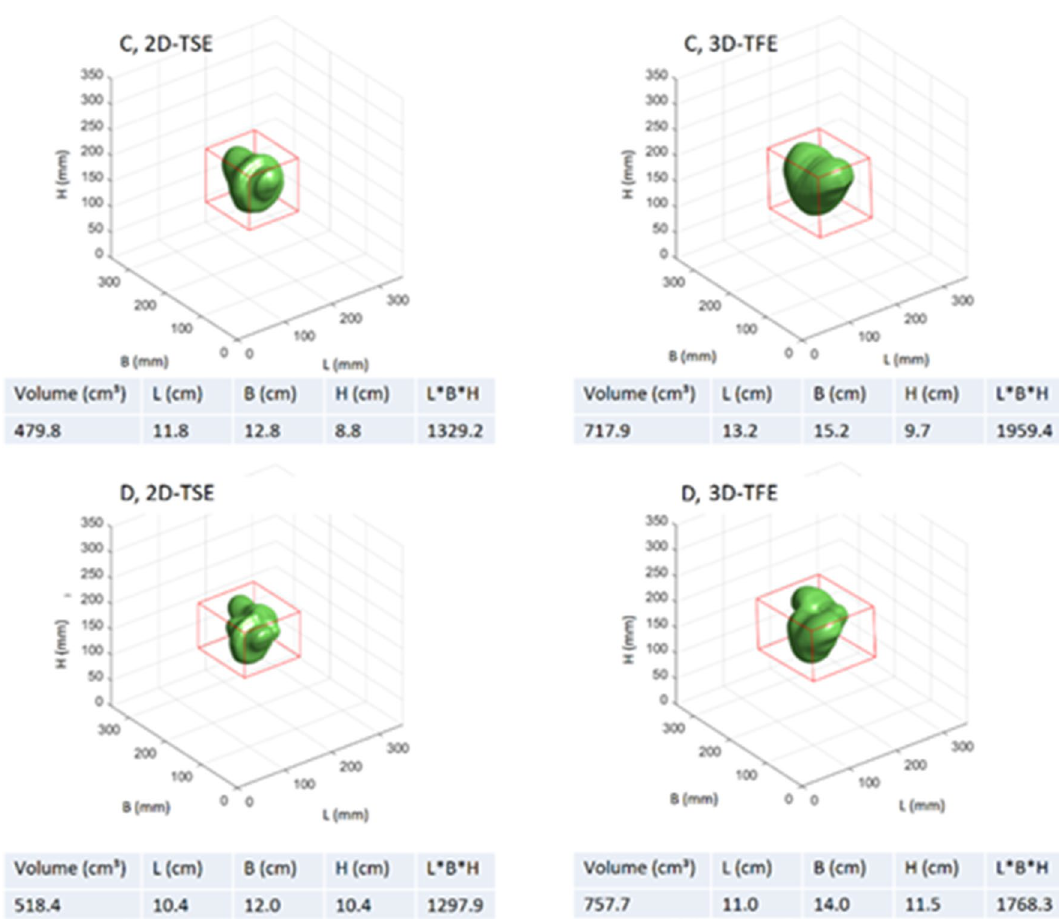
Figure 6. Generic setups and their artifacts. C describes a centric position of all ferromagnetic material, D the splitting of the ferromagnetic material into two diagonally positioned halves. All scans were performed in orientation 1. The red boxes mark the bounding box dimensions. The absolute values of the boundary box are given below the coordinate